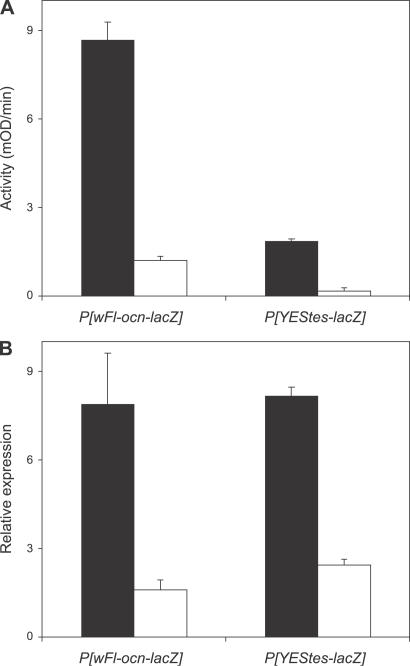
Expression Levels of Autosomal (Solid Bars) and X-Linked (Open Bars) Insertions of the Two ocn-lacZ Transformation Vectors Shown in Figure 1
(A) Average β-galactosidase activity of adult males.(B) Relative expression measured by qRT-PCR. Transcript abundance was standardized to that of the ribosomal protein gene RpL32 and is given in arbitrary units. Error bars indicate the standard error of the mean, calculated from the variance among the means of the independent insertion lines.